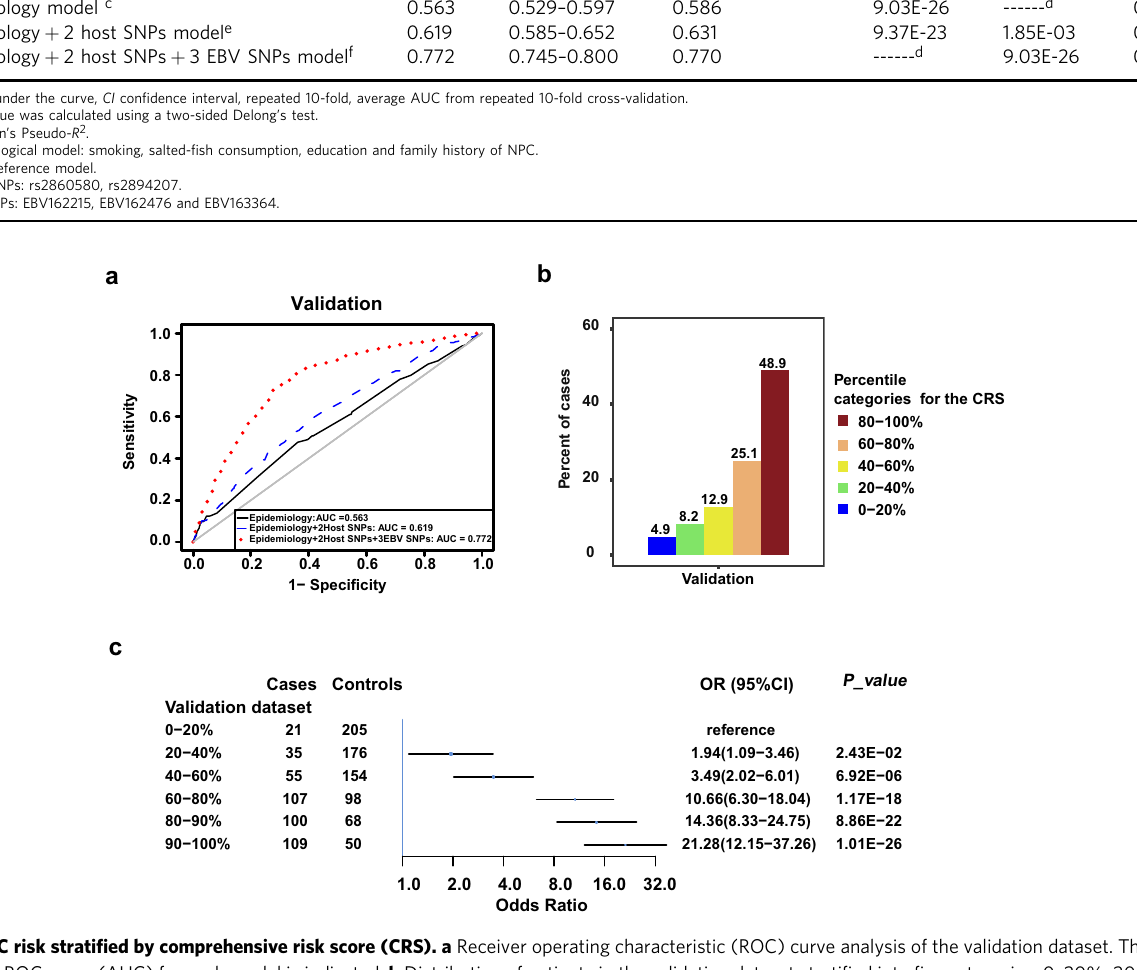
pseudo- R 2 = 0.23, P value of Pearson chi-squared goodness-of- fi t